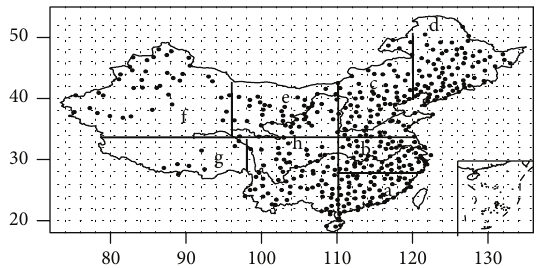
Figure 3: The map of climate regions in